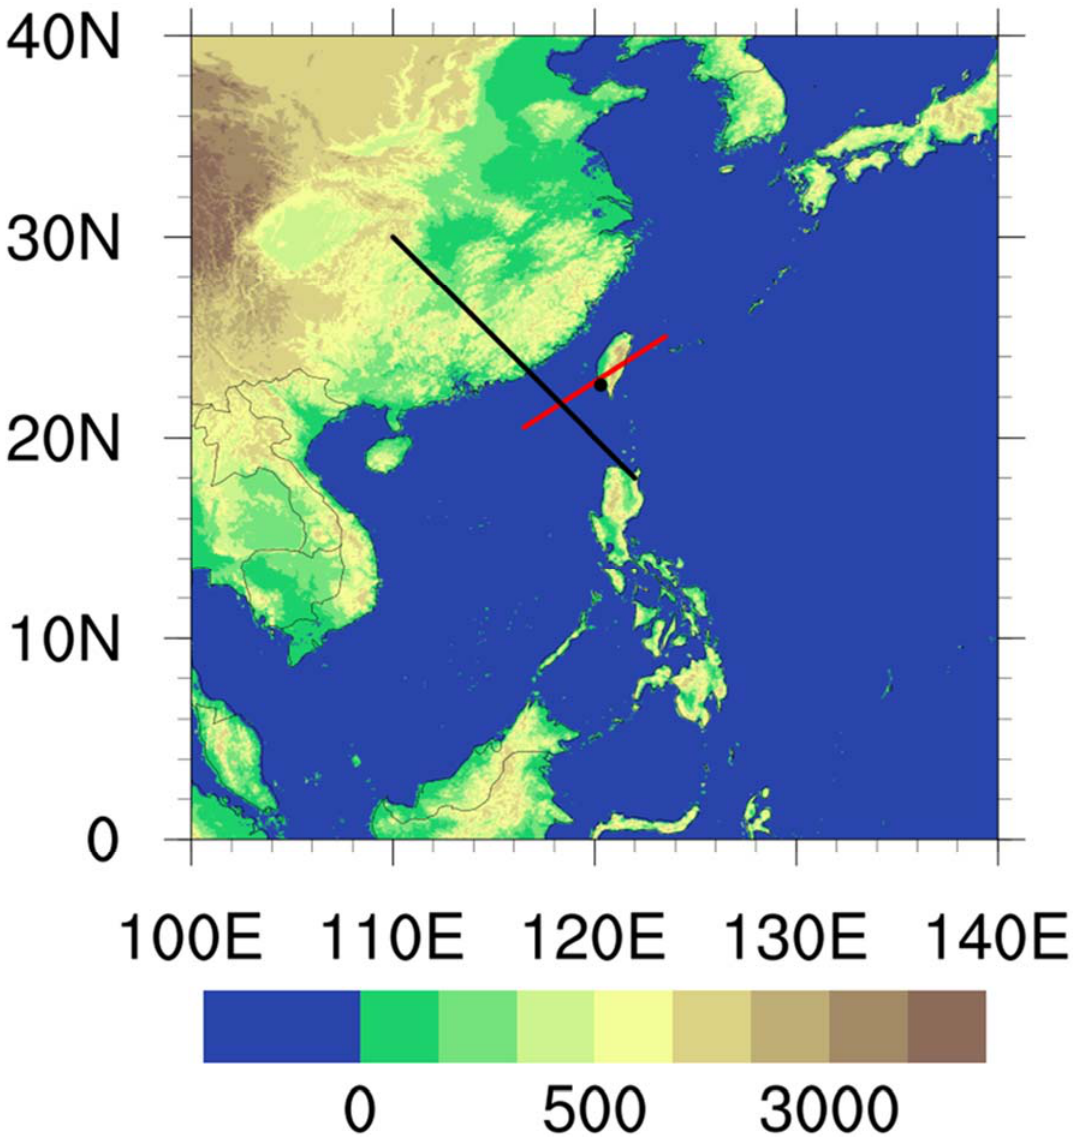
Figure 1. Terrain height (m). The black line is the NW–SE cross-section line. The red line is the NE–SW cross-section line. The black dot indicates the location of Kaohsiung City. The vertically integrated water vapor transport ( IVT ) [19,23,24] is defined as